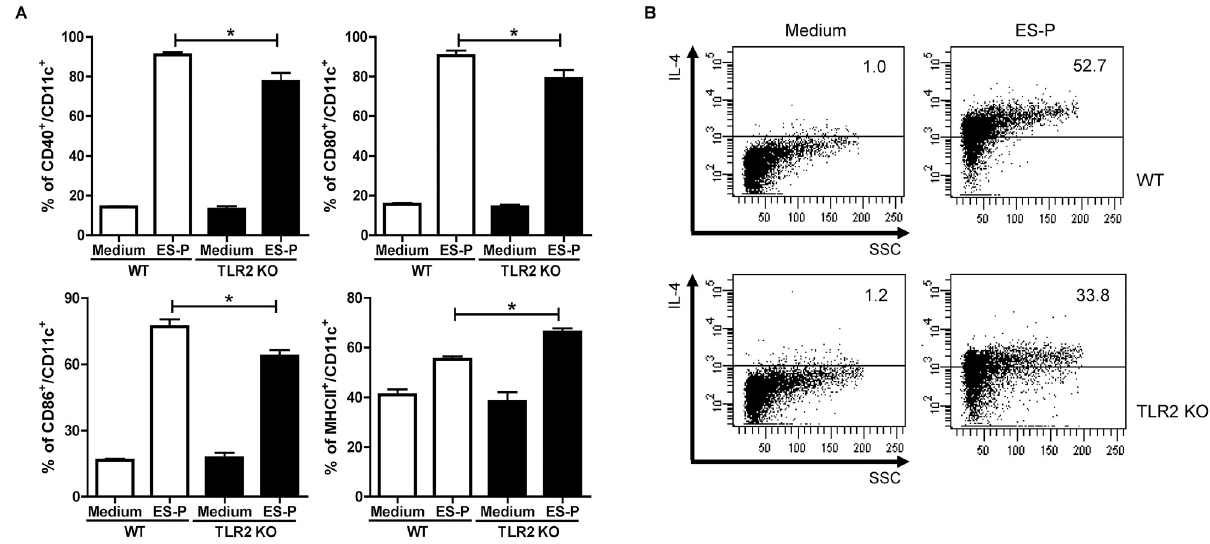
Fig 5. Comparison of DC surface marker activation and the production of Th2-related cytokine expressing cells. Activated BMDCs surface marker (A) and IL-4 expressing T cells (B) were compared between the WT and TLR2 KO groups. (n = 3/group, 3 independent experiments, � ; p < 0.05, �� ; p < 0. 01, ��� ; p <